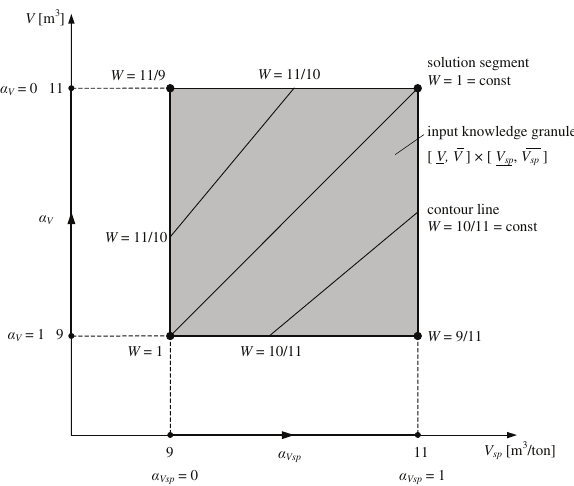
Fig. 9. Illustration of the solution of the same IPVs divi- sion problem from Example 3 projected onto the 2D-space V × V sp . Variables V and V sp are completely independent.